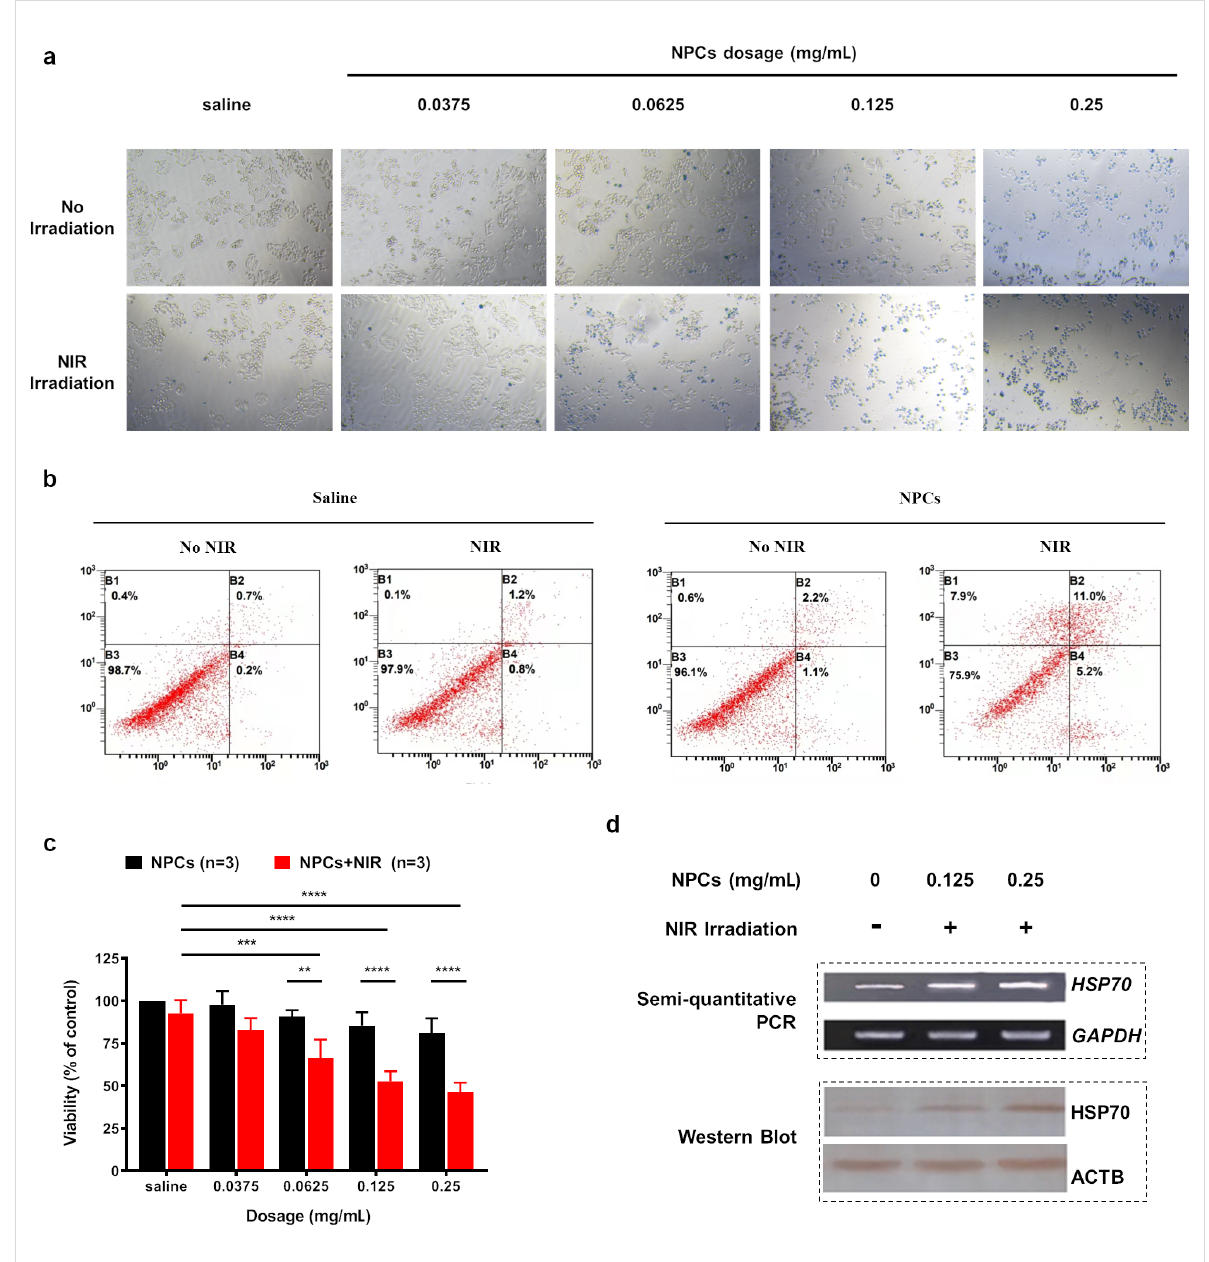
Figure 3: In vitro photothermal ablation of A375 cells. (a) Bright-field microscopy showing the health conditions of A375 cells treated with saline or in- creasing concentrations of NPCs, in the presence or absence of NIR irradiation. Cells were stained with Trypan blue dye to visualize dead cells. (b) Apoptotic and necrotic rates of A375 cells, as revealed by flow cytometry, after photothermal treatment with 0.0625 mg/ml NPCs under 10 min of NIR irradiation. (c) MTT assay showing viability of A375 cells after their incubation with NPCs at different concentrations with or without NIR exposure. ** p < 0.01, *** p < 0.001, **** p < 0.0001 calculated by two-way ANOVA adjusted by Sidak’s multiple comparisons. (d) Expression of HSP70 in A375 cells was increased after treatment with NPCs (0.125 and 0.25 mg/mL) under NIR irradiation. This increase was observed on both mRNA and protein levels as revealed by semi-quantitative PCR and western blot,